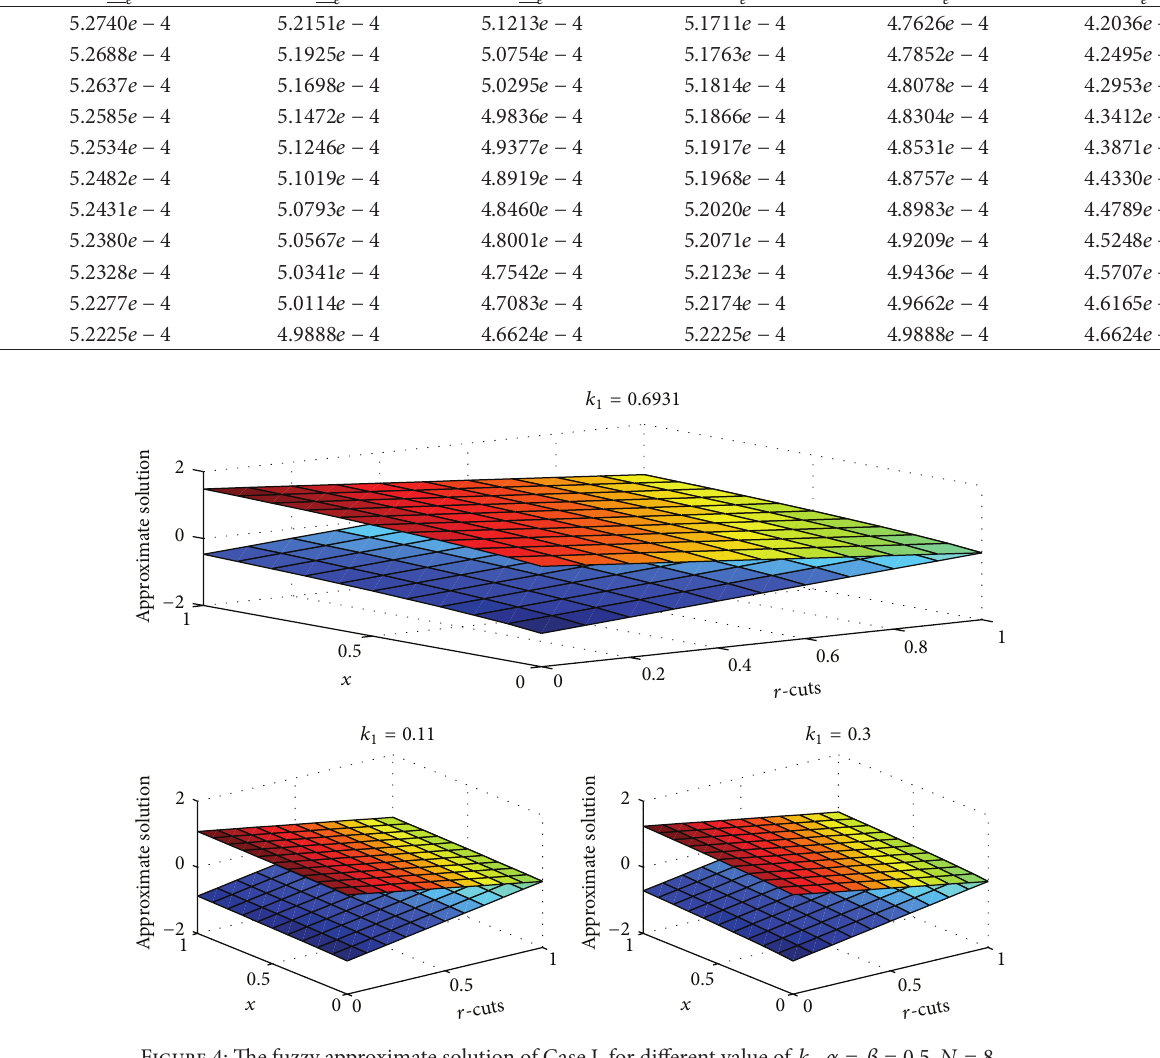
Figure 4: The fuzzy approximate solution of Case I, for different value of 𝑘 1 , 𝛼 = 𝛽 = 0.5, 𝑁 = 8